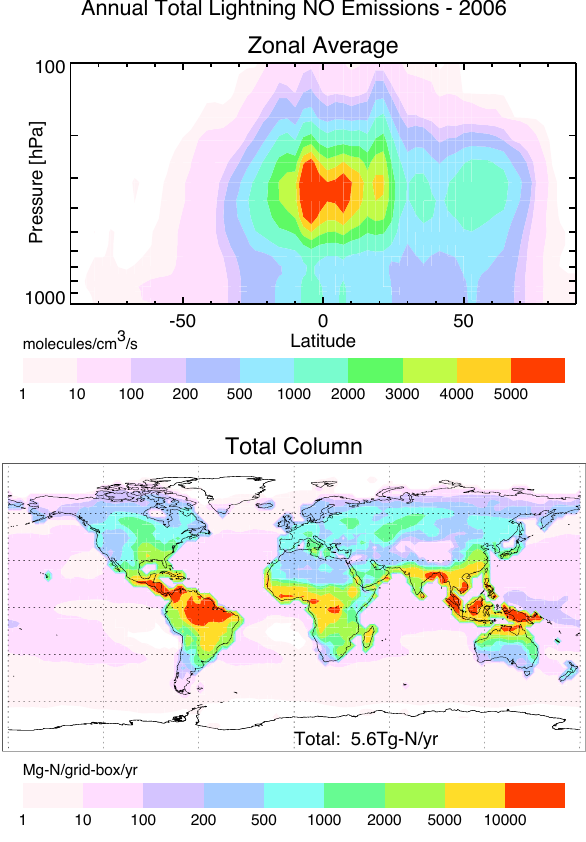
Fig. 2. Emissions of NO from lightning for 2006. Top panel shows the zonal average vertical distribution for the annual aver- age. Bottom panel shows the total column annual total (in Mg-